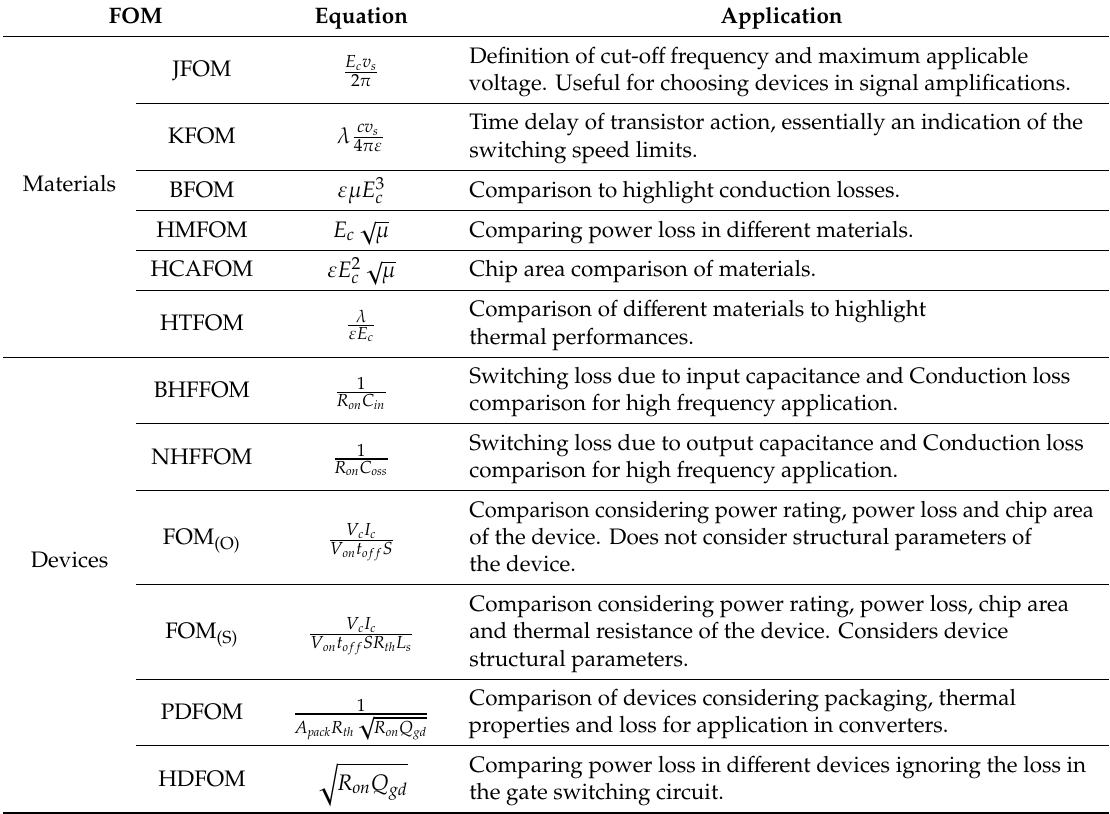
Comparing power loss in di ff erent devices ignoring the loss in the gate switching